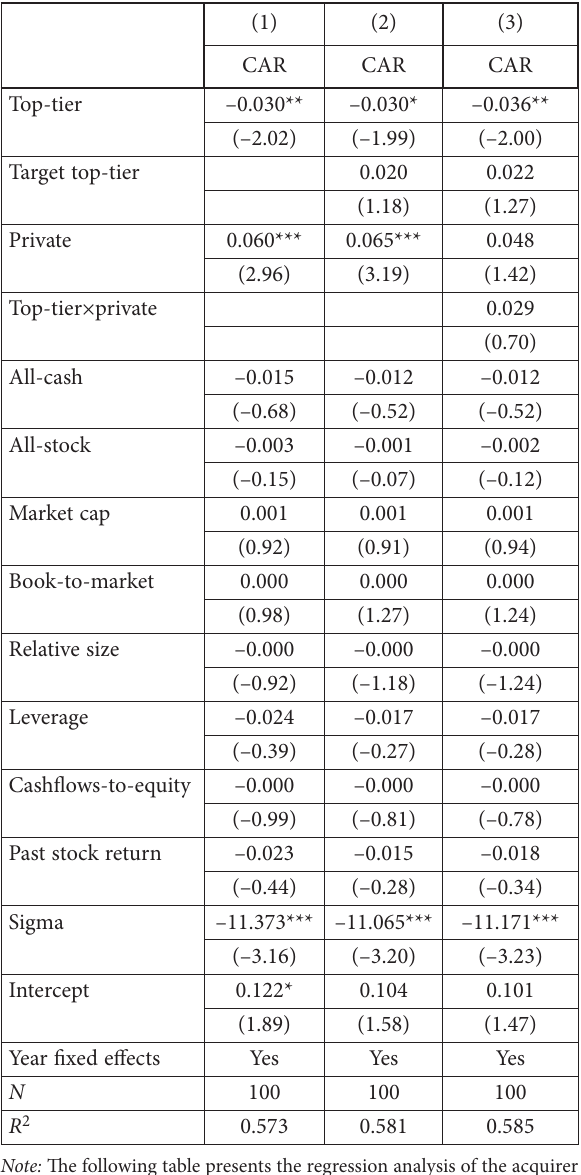
Table 4. Cross-sectional regression analysis of bidder CARs